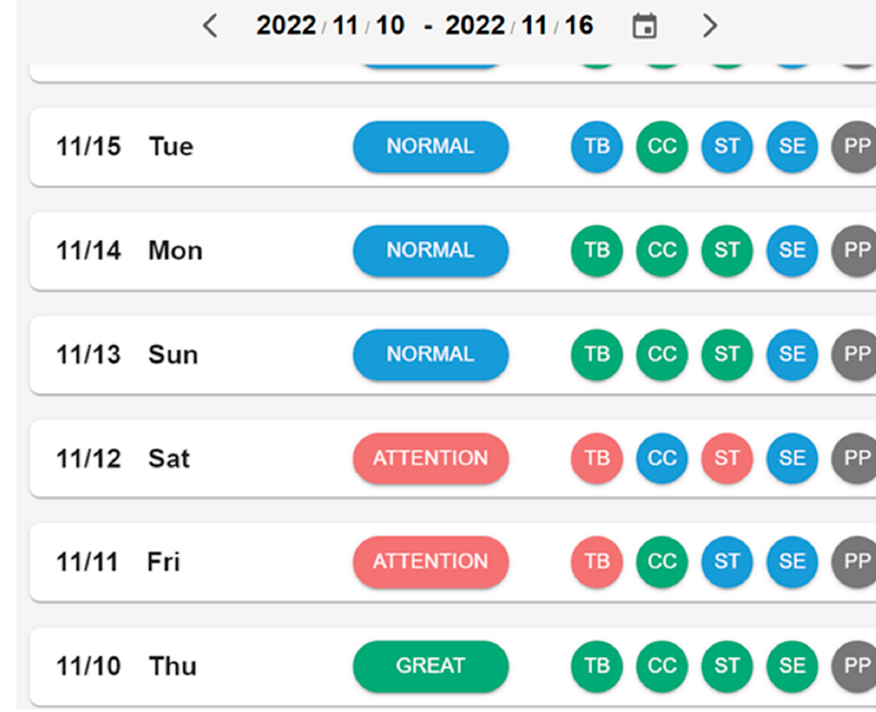
Figure 8. Wellbeing dashboard for seven days.